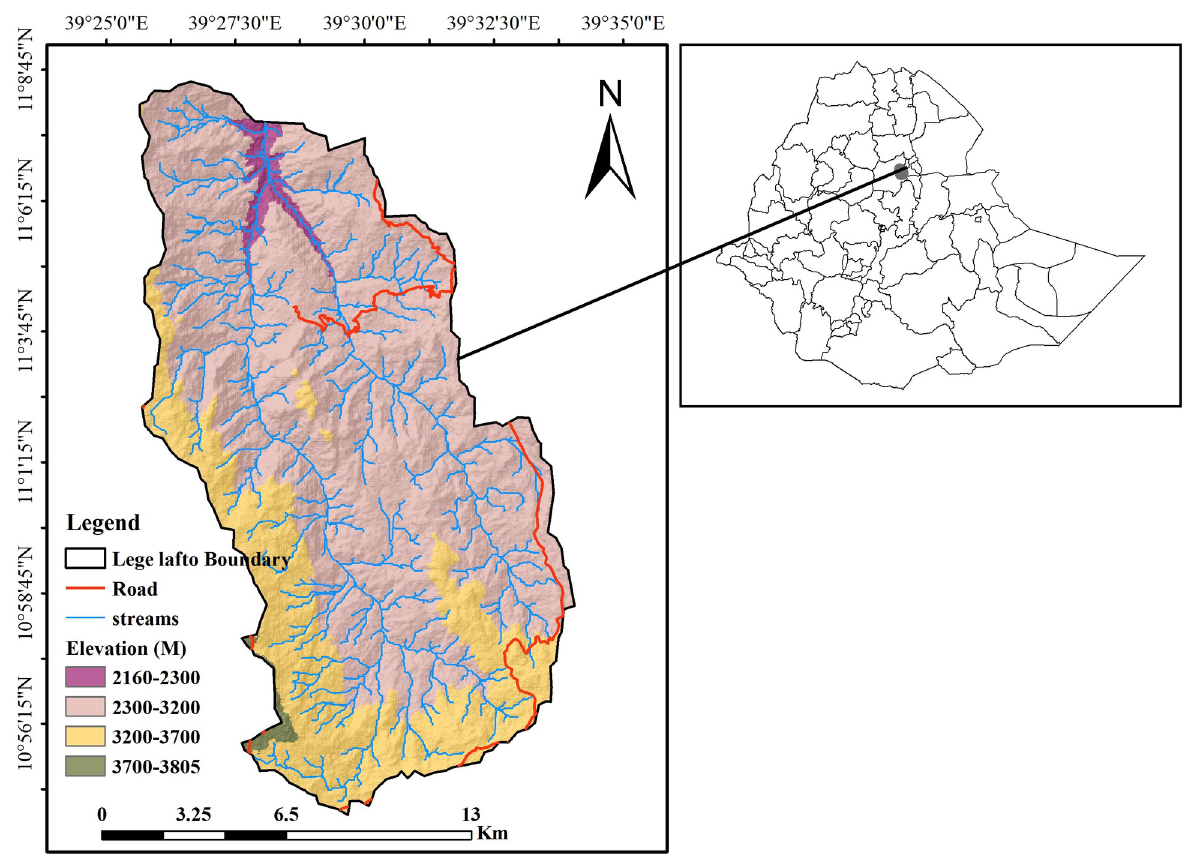
Fig 1. Location of Lege-lafto watershed, Dessie Zuria District, South Wollo, Ethiopia.